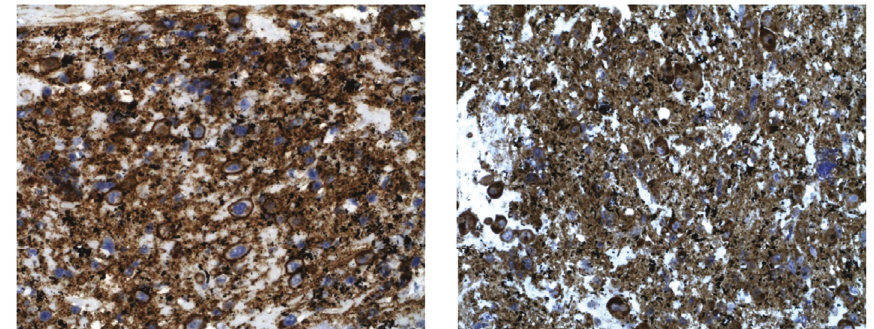
Figure 4: Immunohistochemistry of the FNA sample showed positive staining for CD138 under 400x magnification on the left side and positive staining for Lambda light chain under 400x magnification on the right